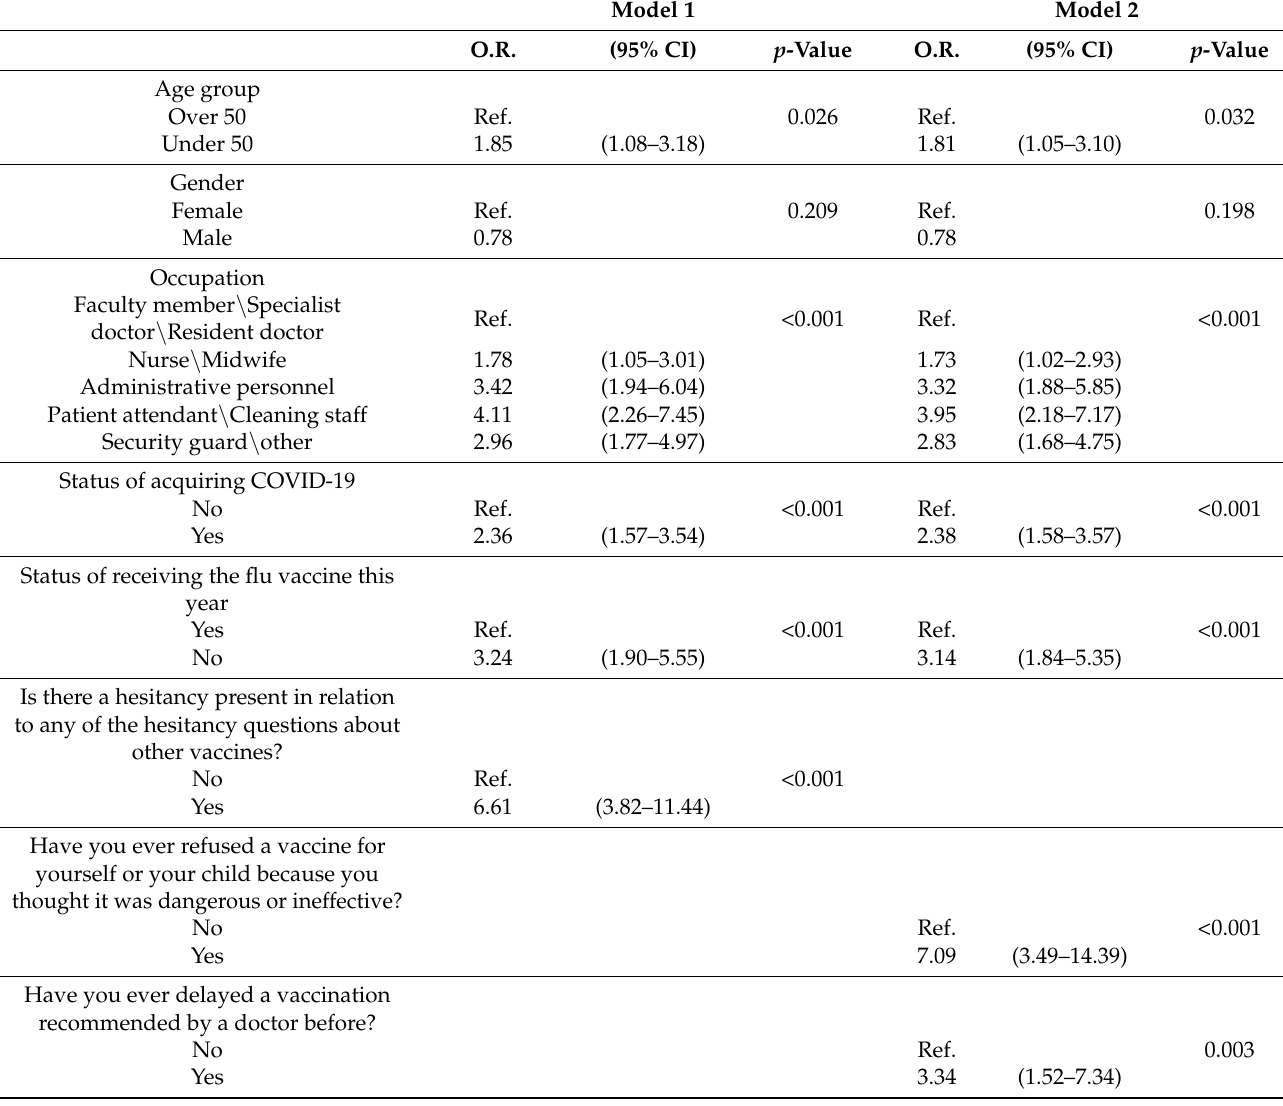
Table 3. Evaluation of the variables that may have an impact on not getting vaccinated or its postponement, by using multivariate logistic regression